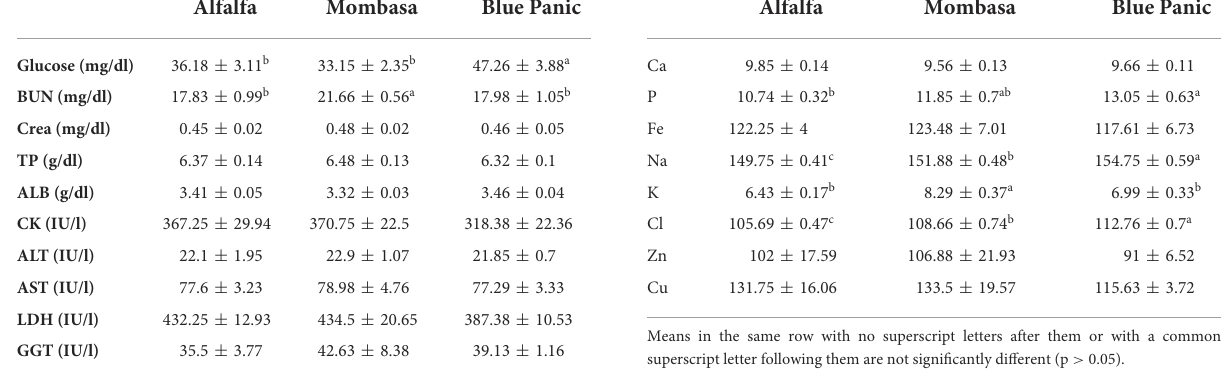
TABLE 5 Serum metabolites in growing goats fed alfalfa, Mombasa, or blue panic. Alfalfa Mombasa Blue Panic